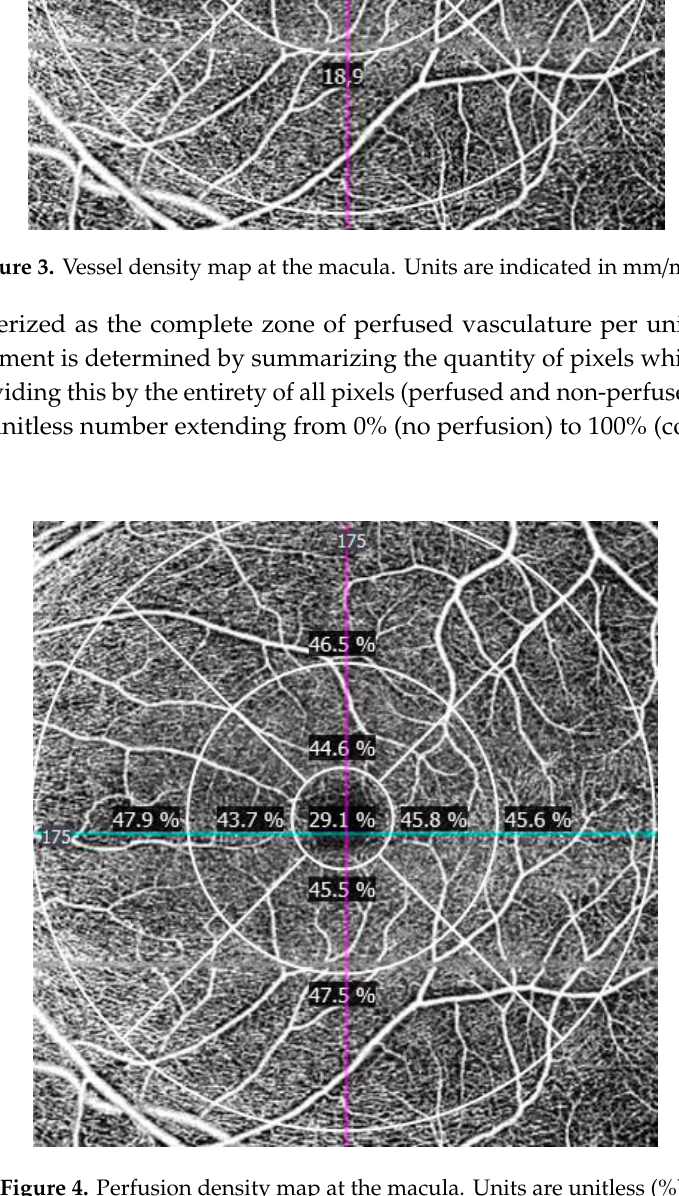
Figure 3. Vessel density map at the macula. Units are indicated in mm/mm 2 .